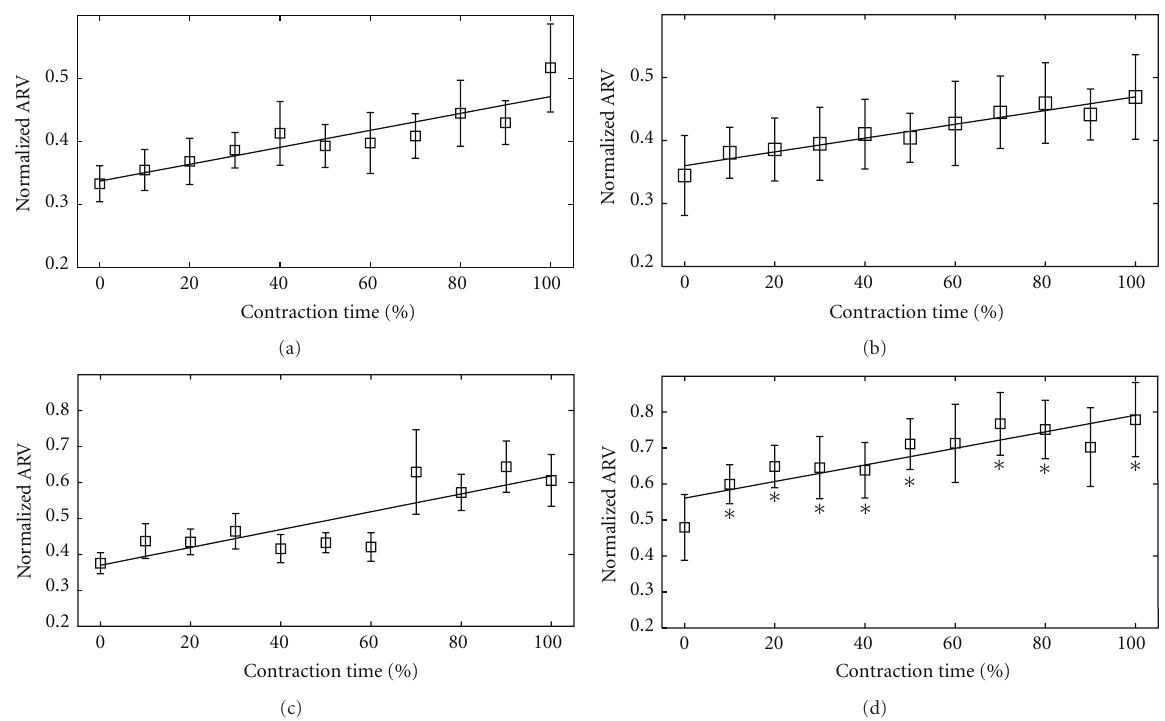
Figure 2: The changes of the mean normalized ARV ( ± SE) over the normalized contraction time during the prefatigue (a) and refatigue (b) tasks of the LEDT group and the prefatigue (c) and refatigue (d) tasks of the passive rest group. The symbol “ ∗ ” indicates that the di ff erence between the mean normalized ARV values of the two groups in the corresponding normalized contraction time is statistically significant.